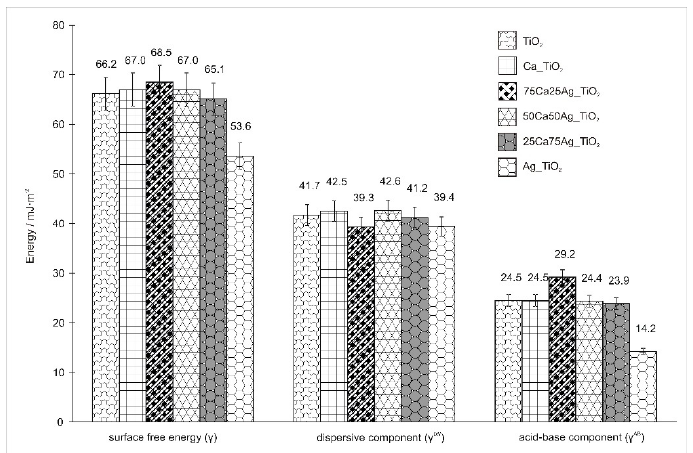
Figure 8. Surface free energy γ values (with distinction between dispersive and polar components) of the titania-based coatings doped with Ca and Ag ions in different molar